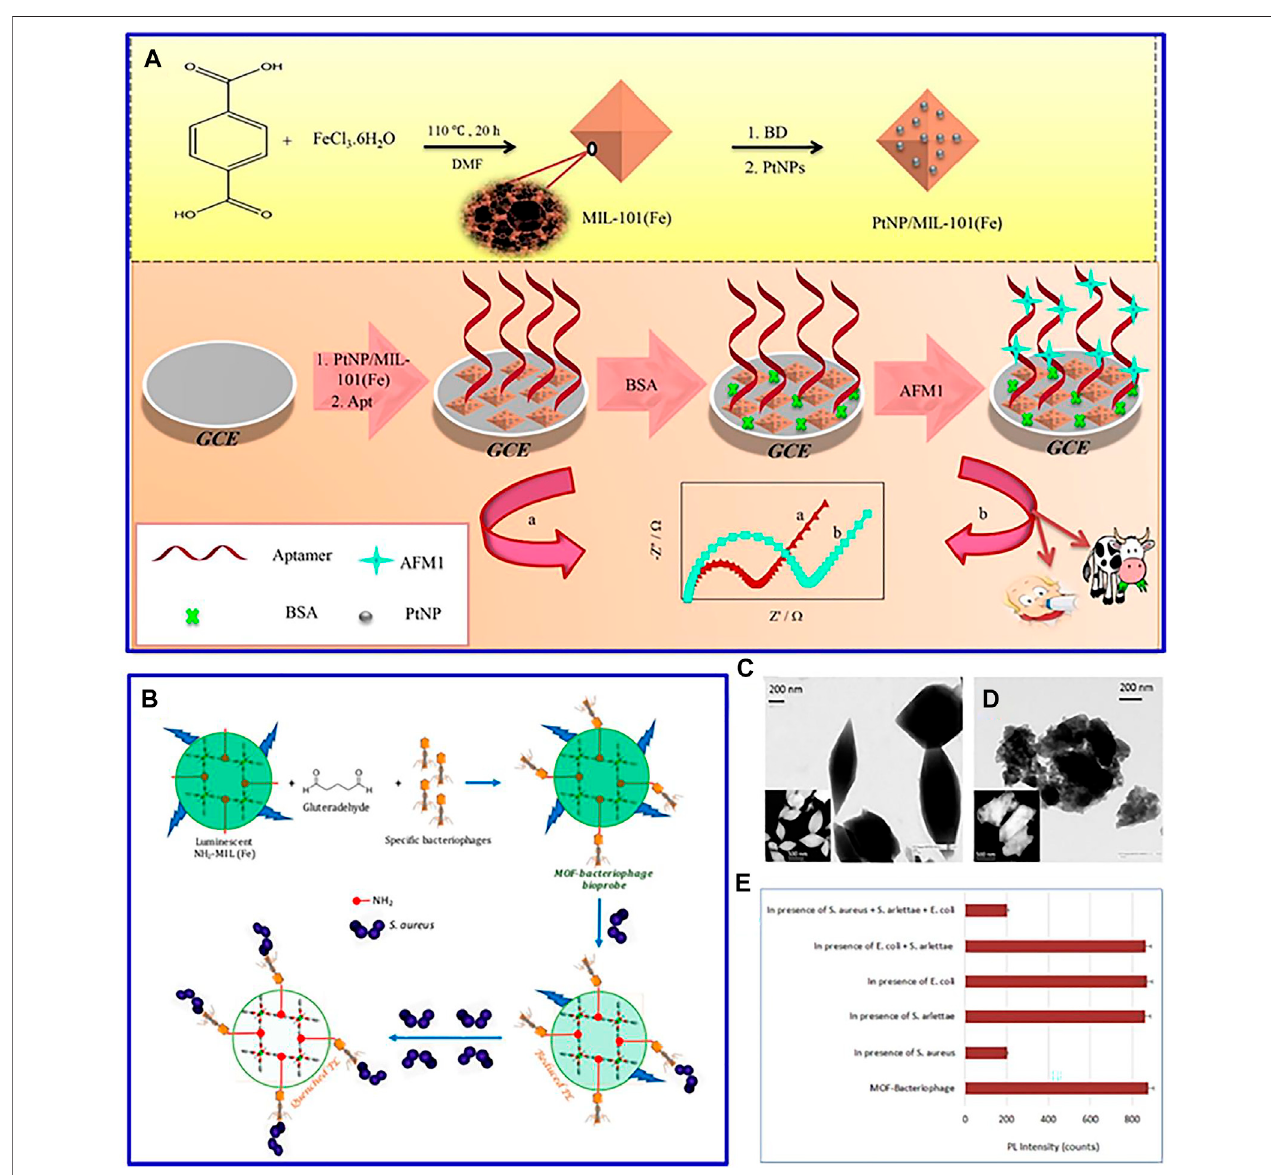
FIGURE5|(A) Schematicdiagramforthepreparationschematicdiagramand electrochemicaltest ofPtNP/MIL-101(Fe).Reproduced withpermission (Jahangiri- Dehaghani et al., 2020). Copyright 2020, Elsevier. (B) Schematic of NH 2 -MIL53(Fe)-bacteriophage biosensor; TEM image of (C) NH 2 -MIL-53 MOF and (D) bacteriophage-loaded NH 2 -MIL-53 MOF; (E) speci fi city of the proposed biosensor. Reproduced with permission (Bhardwaj et al., 2017). Copyright 2017, ACS.